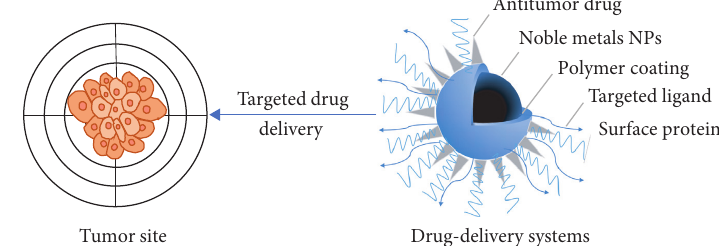
Figure 8: Brief schematic of drug delivery